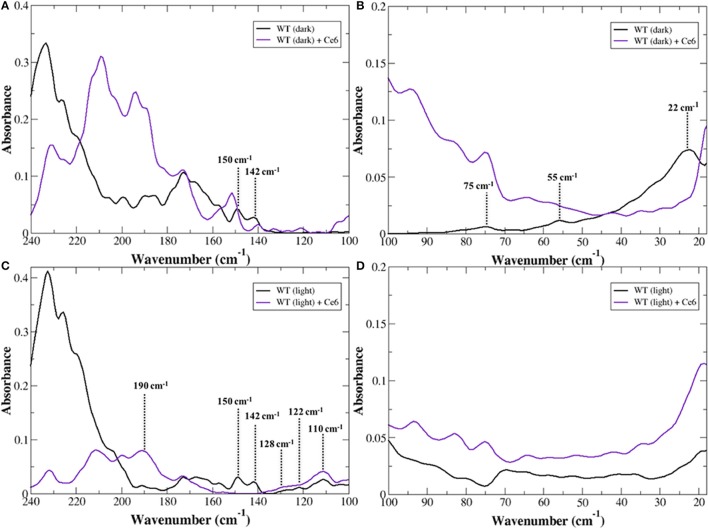
Experimental THz spectrum of dark-state rhodopsin in the unbound state (black line) and when bound with Ce6 (purple line) in the (A) 240–100 cm−1 spectral region and in the (B) 100–20 cm−1, spectral region. Experimental THz spectrum of Meta-II in the unbound state (black line) and when bound with Ce6 (purple line) in the (C) 240–100 cm−1 spectral region and in the (D) 100–20 cm−1 spectral region.